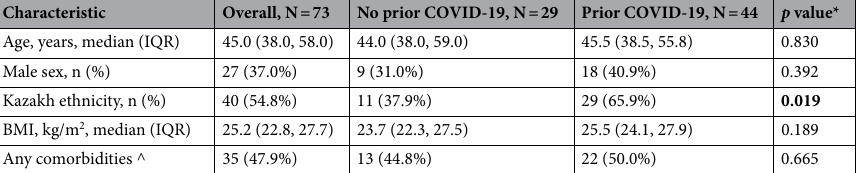
Table 1. Characteristics of study participants. *Differences between the Prior and No Prior COVID-19 groups were assessed using Mann–Whitney U or Pearson’s Chi-squared tests. We estimated that most of the prior COVID-19 occurred ~ 8–12 months prior to study enrolment (see the Methods). ^Comorbidities consisted of self-reported gastrointestinal conditions, hypertension, chronic heart disease, chronic obstructive pulmonary disease, history of malignancy, diabetes, liver disease, thyroid dysfunction, kidney disease, neurologic conditions, autoimmune conditions; the distribution of individual comorbidities did not differ between the “no prior COVID-19” and “prior COVID-19” groups. Significant values are in